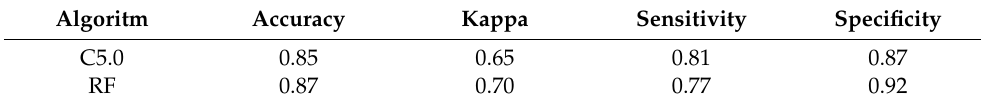
Table 6. Relevant information about predictions by machine learning algorithms.